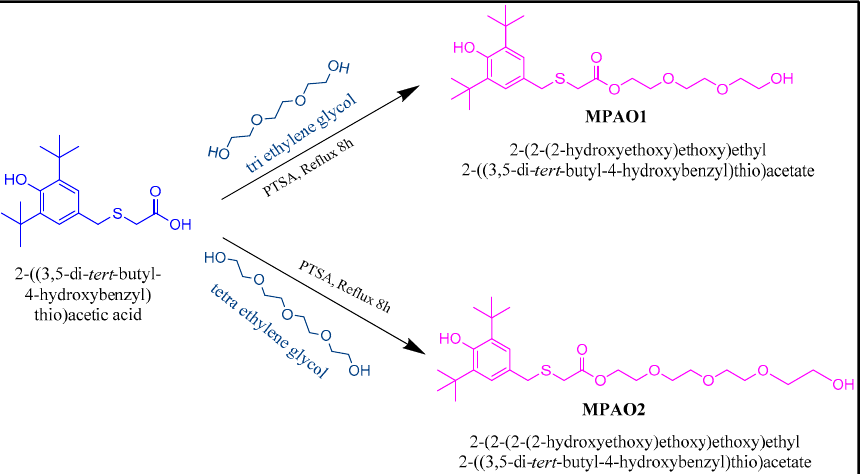
Scheme 1. Synthesis of